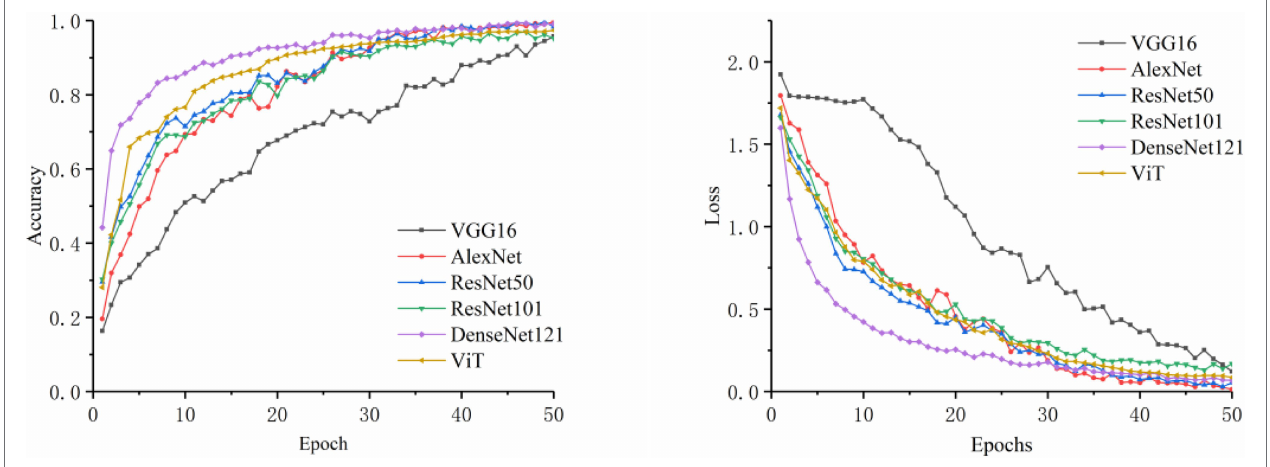
FIGURE 4 | Comparison of accuracy and loss for original image classification.